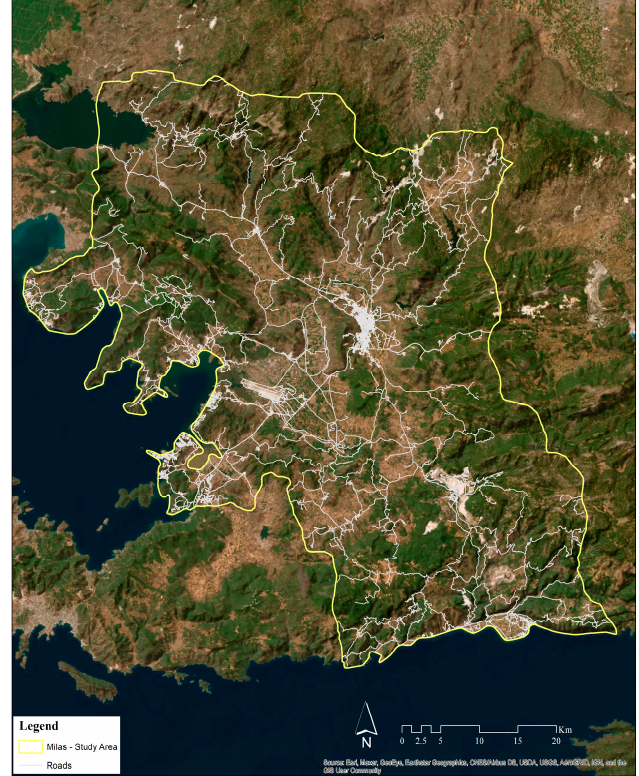
Figure 12. Roads. Figure 12.